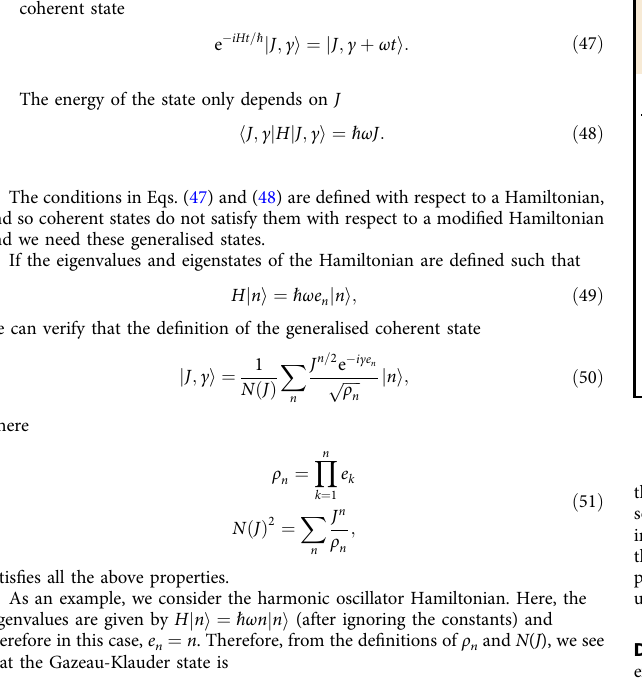
from Fig. 3 of the paper, setting the fi gure as a plot background and plotting markers over the fi gure such that the plot points coincide exactly with the points in the background. The coordinates of the plotted points were recorded as the extracted data. Data availability All data generated or analysed during this study are extracted from ref. 26 and are available in this article in Table 1.